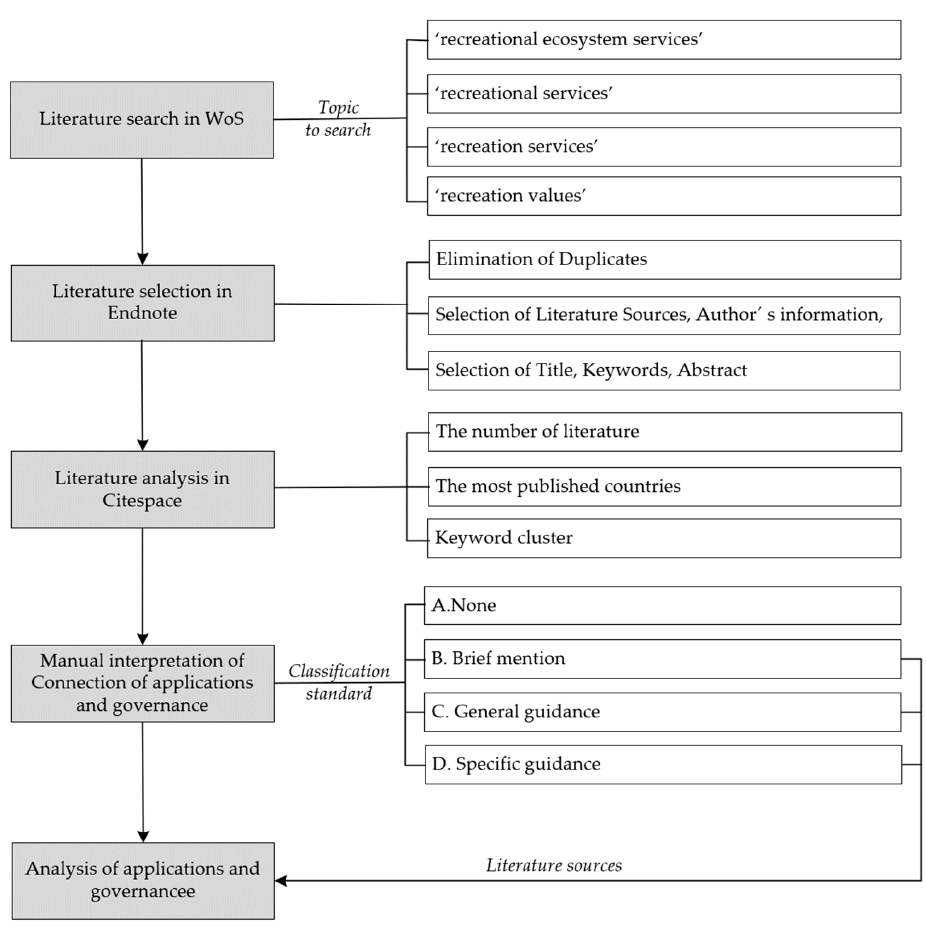
Figure 1. Flowchart of research methodology.